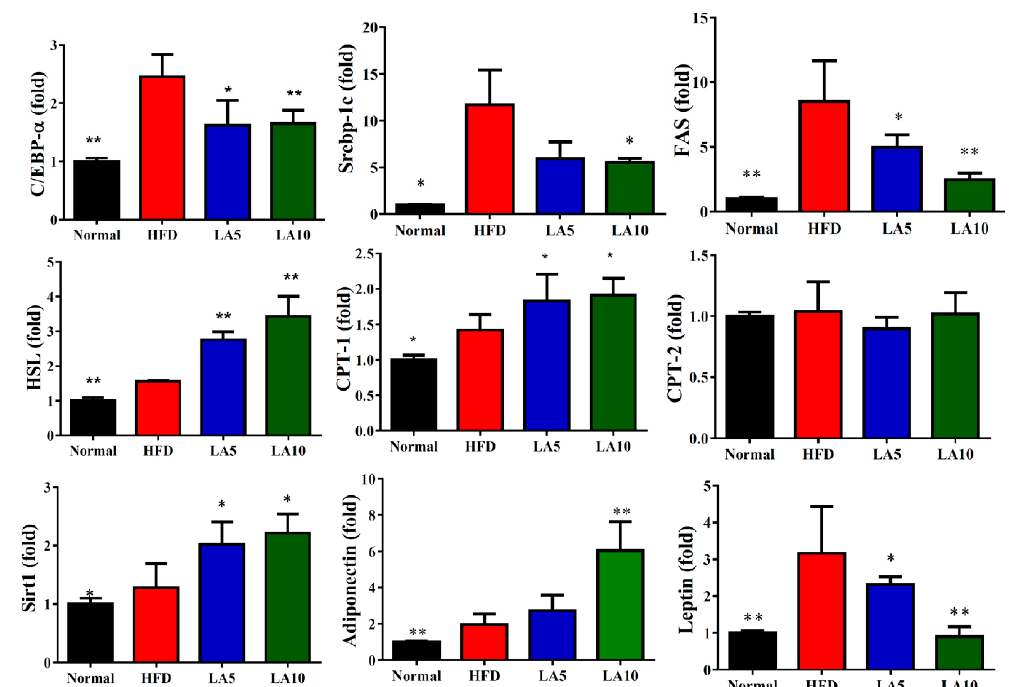
Figure 5. Licochalcone A (LA) modulated lipogenesis and lipolysis gene expression in liver tissue. Gene expression levels were determined using real-time PCR. * p < 0.05, ** p < 0.01 compared with mice with HFD-induced obesity.